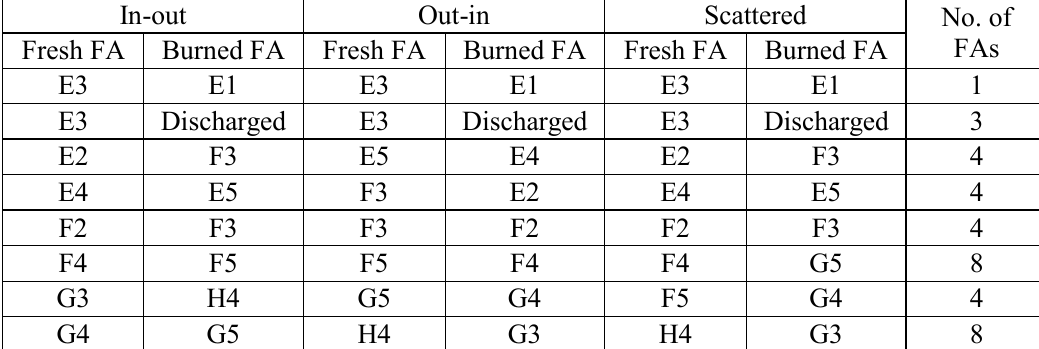
Table II: The Proposed Fuel Shuffling Schemes for the ATOM Core In-out Out-in Scattered No. of